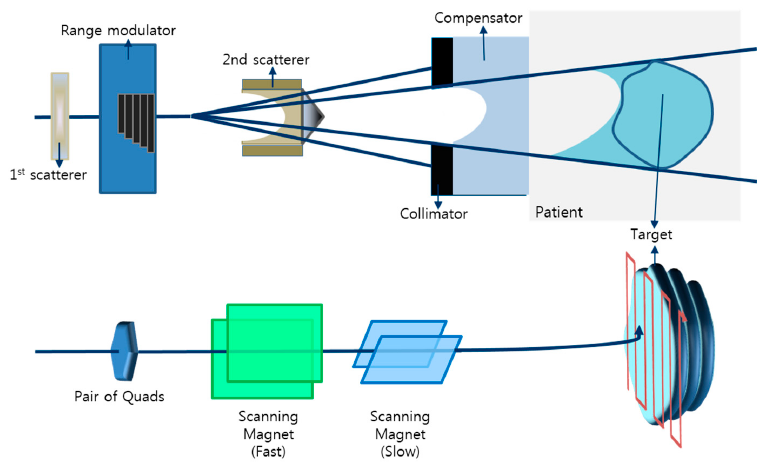
Figure 1. Proton beam delivery techniques: Passive scattering mode ( upper panel ) and Pencil beam scanning mode ( lower panel ).